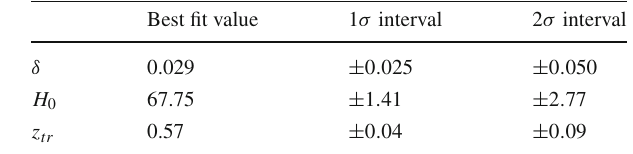
Table 1 Best fit values of the model parameters δ , H 0 and z tr , together with their 1 σ and 2 σ confidence intervals for the linear case φ( z ) =